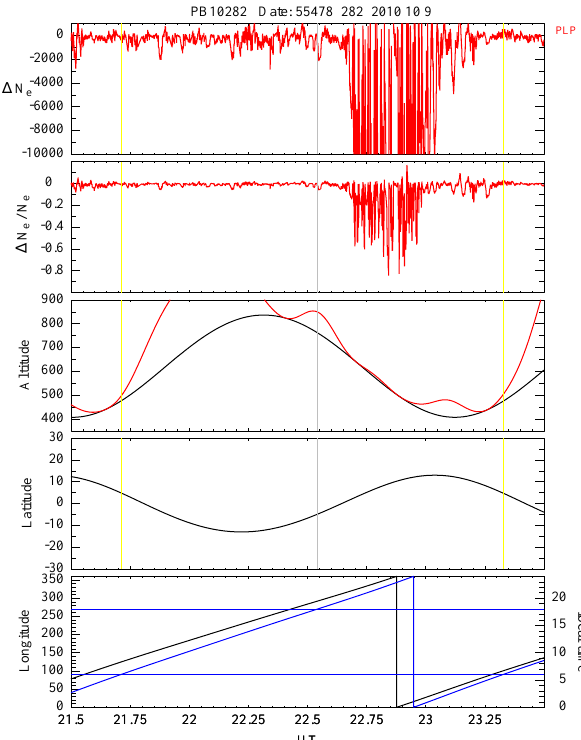
Fig. 2. The plasma density perturbation observed by PLP onboard the C/NOFS satellite on day 281 of 2010, at around 22 UT. The top panel gives the density perturbation (red curve, in number per cm 3 ) determined by high-pass filtering of the observations. The sec- ond panel gives the density perturbation normalized by the ambient density. (The gray lines in these panels mark the time of 18:00LT, the yellow lines the time of 06:00LT.) The third panel gives the alti- tude of the satellite at the time of the observation (black curve) and the apex altitude of the observation point mapped back to the geo- magnetic equator (red curve). The fourth panel gives the latitude of the observation, while the bottom panel gives the longitude (black curve, left-hand scale) and local time (blue curve, right-hand scale) of the observations.